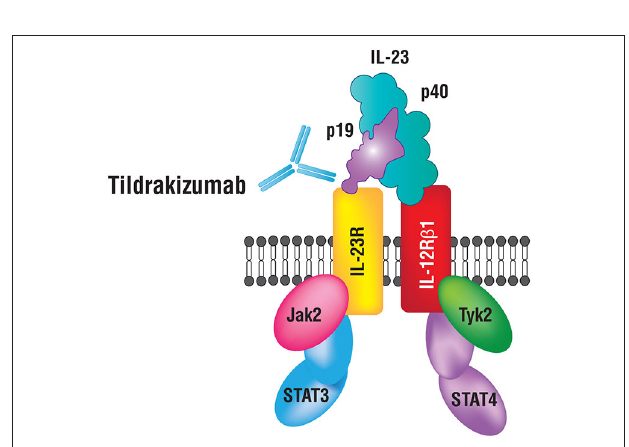
FIGURE 2 | IL-23 and its receptor complex. IL-23 is a heterodimeric cytokine composed of p40 and p19